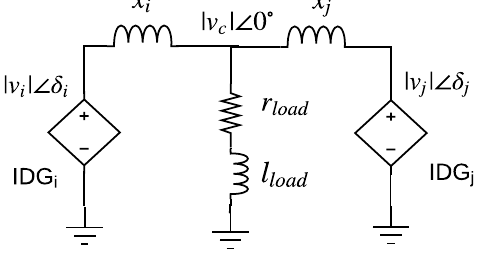
Figure 3. Equivalent circuit of the MG